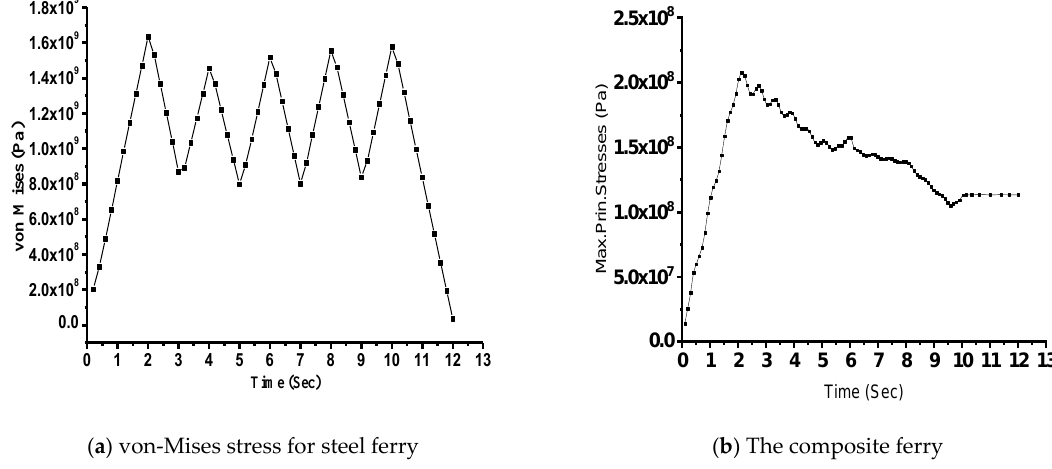
Figure 34. Stresses change with time for case 4.